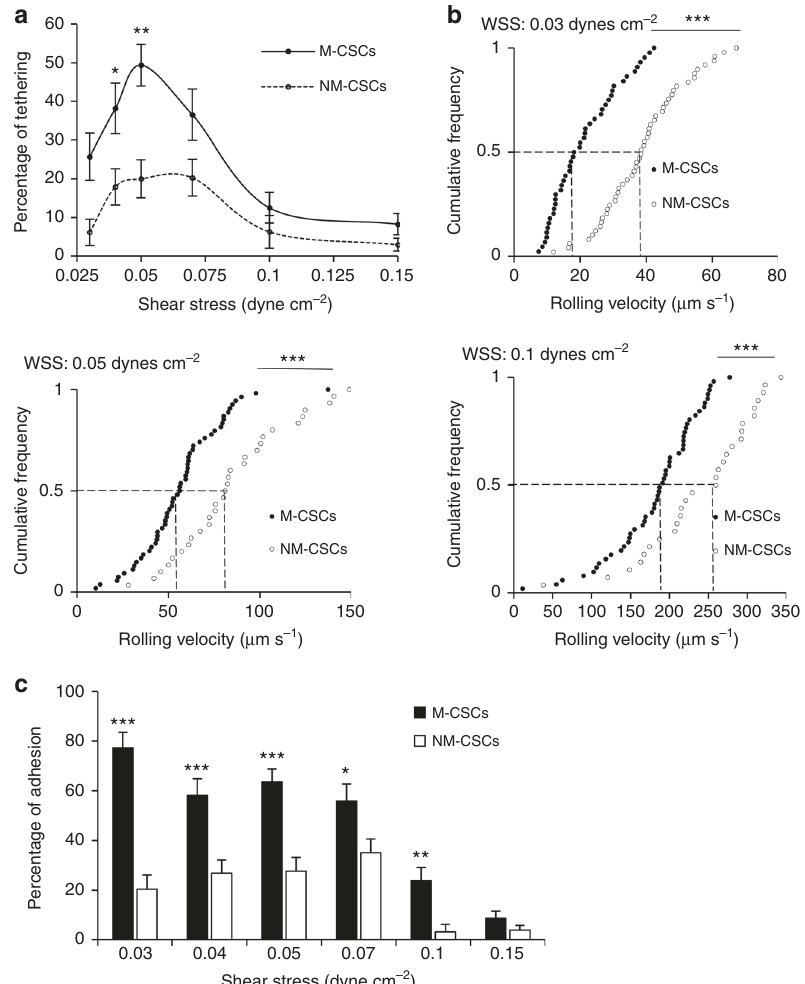
Fig. 2 Differential capabilities of M- and NM-CSCs in rolling adhesion on HPMCs. a Percentage of tethering of M-CSCs and NM-CSCs on HPMCs. b CSCs rolling velocities on HPMCs monolayers. Each dot represents individual cancer spheroid. Dash lines: median velocity of two cell lines. c Percentage of adhesion of M-CSCs and NM-CSCs on HPMCs under different shear stress. Results are representative of three independent experiments. Error bars indicate SEM of the mean. n = 44/49 (0.03), 35/43 (0.04), 54/30 (0.05), 52/74 (0.07), 51/28 (0.1), 92/103 (0.15). Statistical analysis using chi-square test a , c and one-tailed unpaired Student ’ s t test b . ns, not signi fi cant. * P < 0.05; ** P < 0.01; *** P <